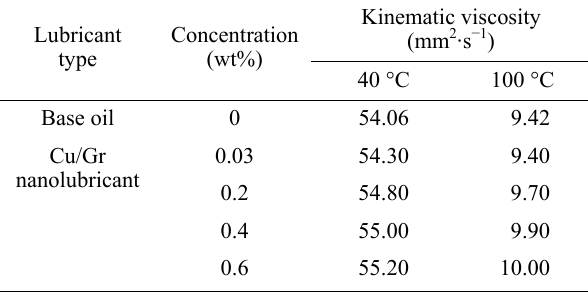
Table 1 Kinematic viscosity of the Cu/Gr hybrid nanolubricants.